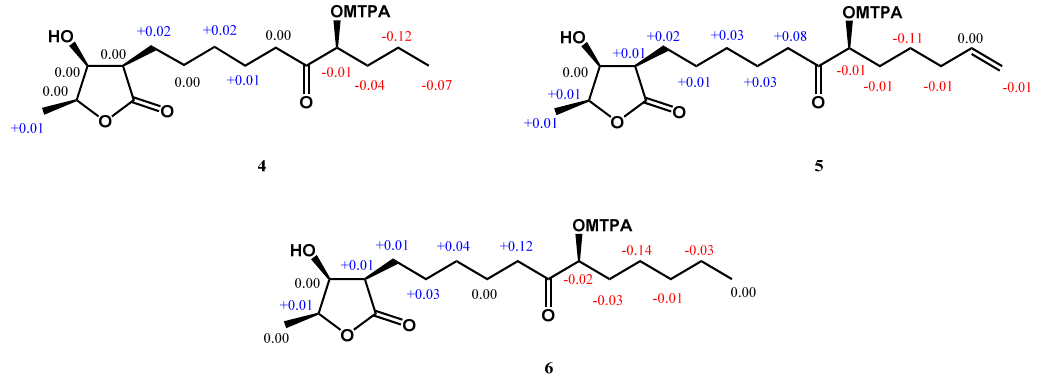
Figure 5. Results with the modified Mosher’s method ( 𝛥𝛿 S − R ) of machinolides D–F ( 4 – 6